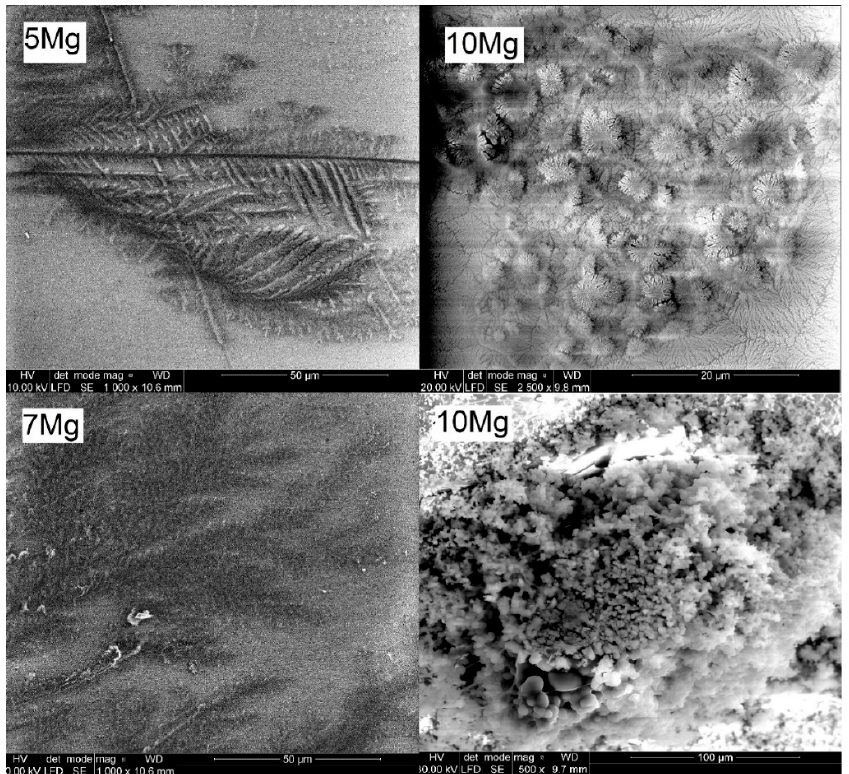
Figure 10. SEM micrographs after 8 (top) and 15 (bottom) days of incubation in the PBS for exem- plar glasses. plar